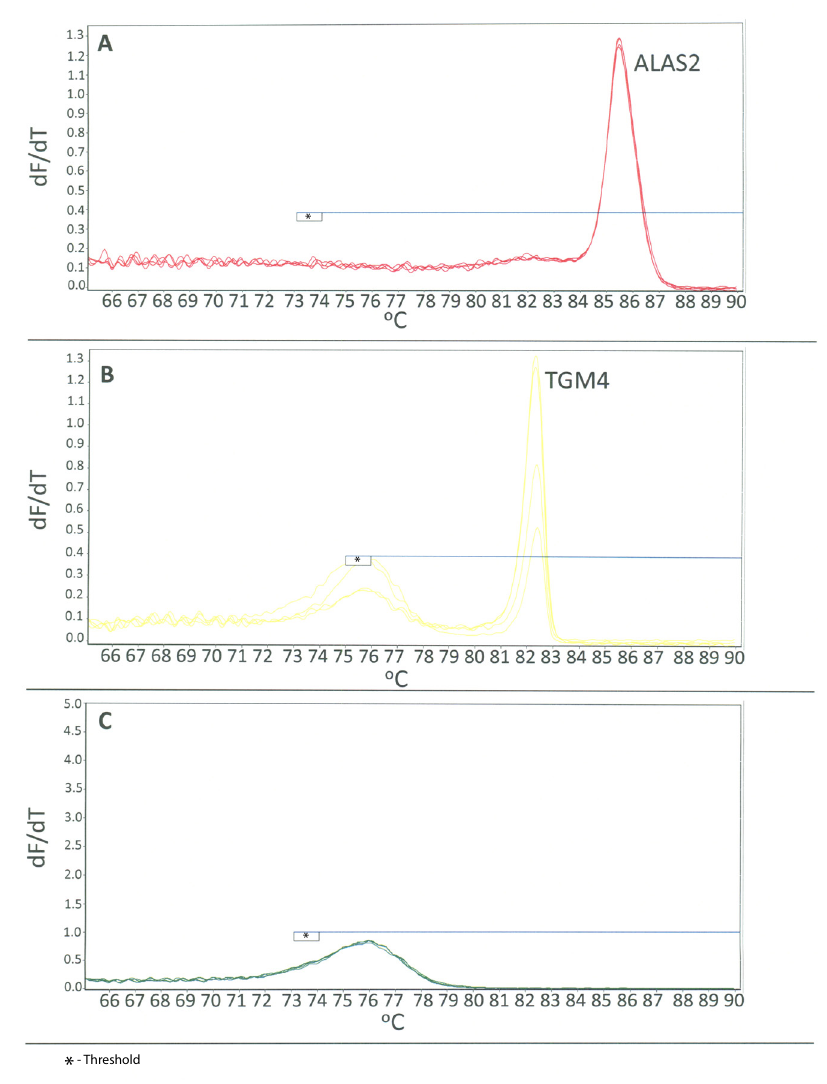
Figure 4. Mixtures. A two-body fluid mixture sample set containing different proportions of the two body fluids was created using a constant amount of blood (50 μl) and decreasing volumes of semen (50 μl, 25 μl, 10 μl, and 5 μl). The admixed samples were co-extracted and the isolated RNA (25 ng) was analyzed using each of the three duplex assays (A – blood/menstrual blood; B – saliva/semen; C – vaginal secretions/skin). Blood and semen were successfully detected, as indicated by the presence of ALAS2 ( A ) and TGM4 ( B ) in all four mixture